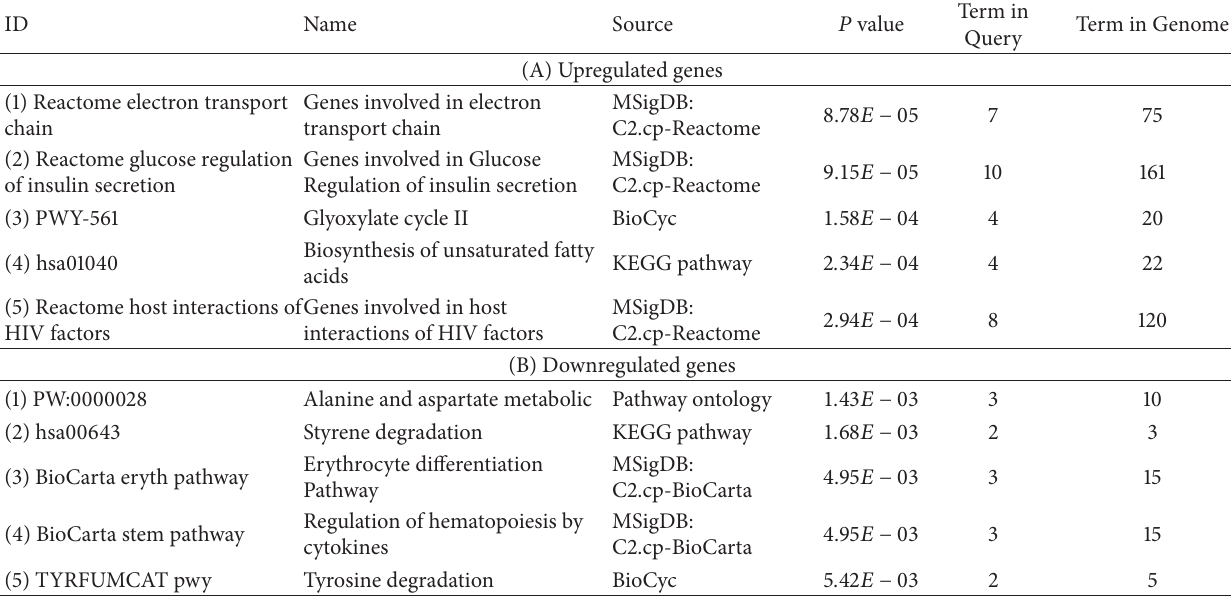
Table 7: Top pathways affected in the liver of mice fed trans -10, cis -12-CLA determined by gene enrichment analysis using the ToppGene suite